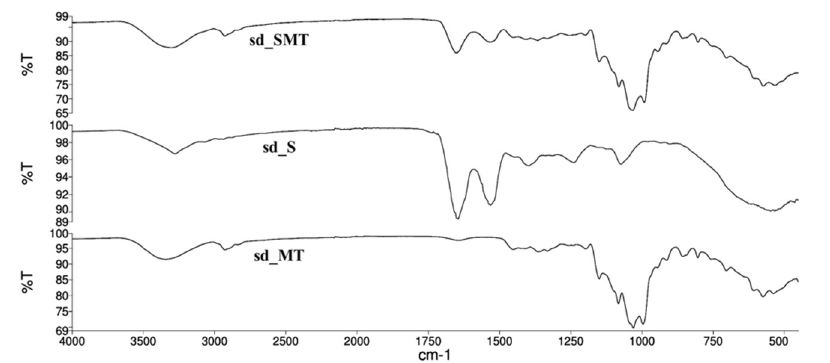
Figure 8. ATR–FTIR spectra of sd_SMT, sd_S and sd_MT powders.